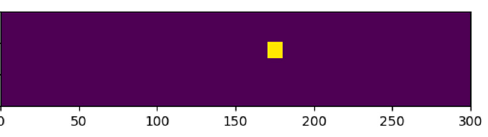
Figure 7. Fracture location (yellow) for bottom surface (axis dimension in mm).